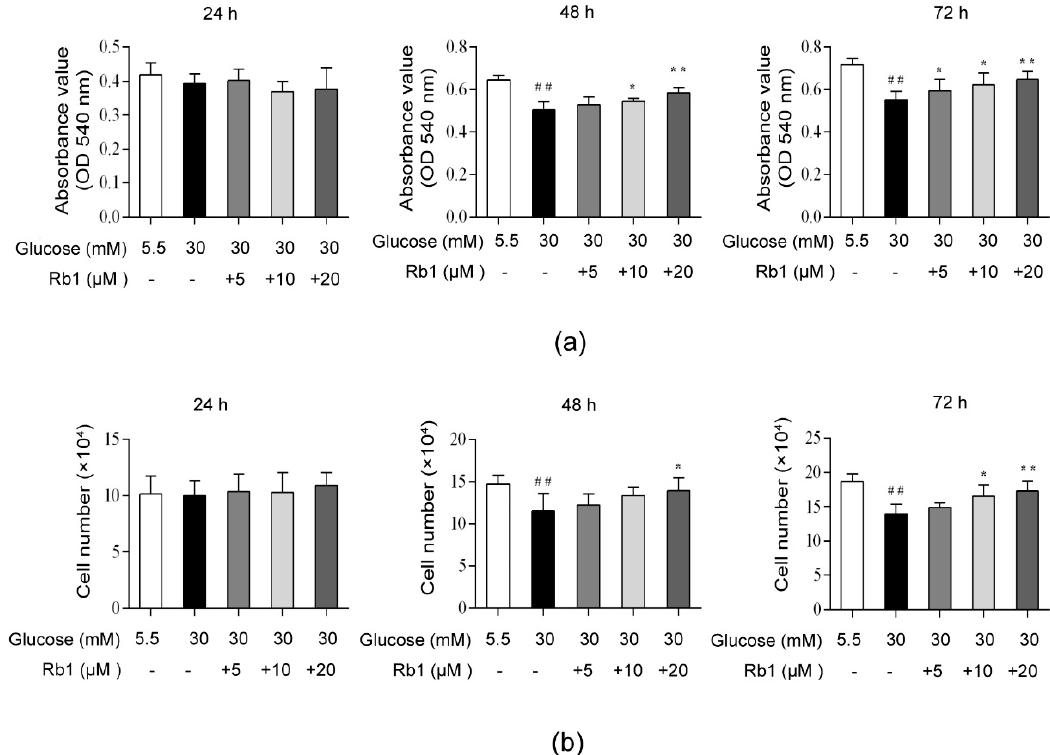
Figure 2. Ginsenoside Rb1 (Rb1) increased the cell viability in rat RCECs exposed to high glucose. ( a ) MTT assays were used to examine the cell viability. ( b ) Trypan blue exclusion was used to count the live cells. The data are expressed as the means ± SD. ## p < 0.01 versus 5.5 mM glucose; * p < 0.05 and ** p < 0.01 versus 30 mM glucose.